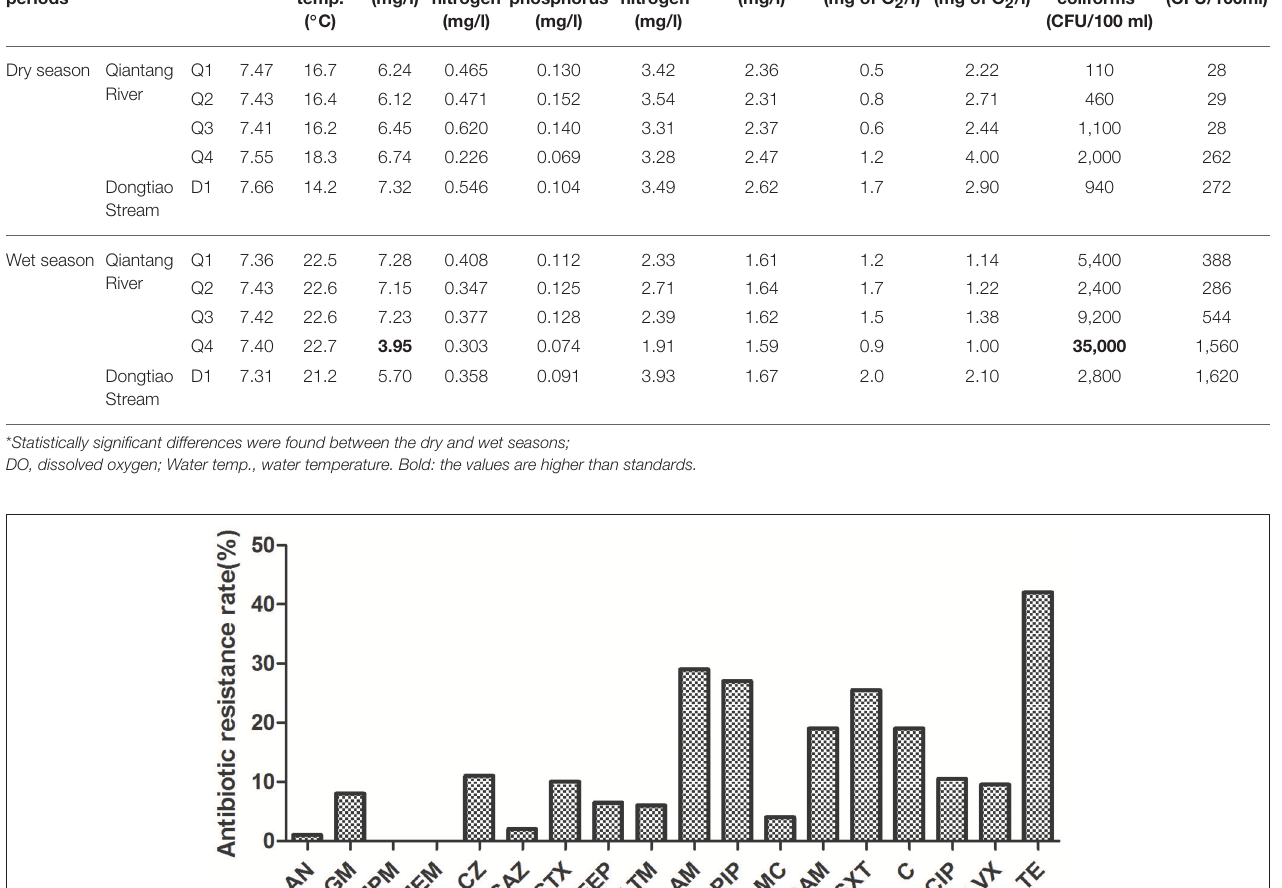
Frontiers in Microbiology |